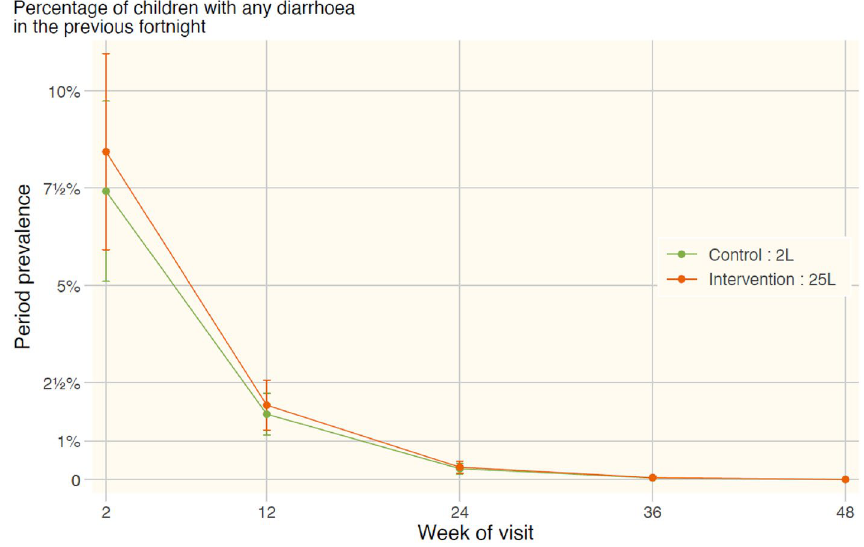
Figure 4. Evolution of the percentage of children with any diarrhoea in the previous